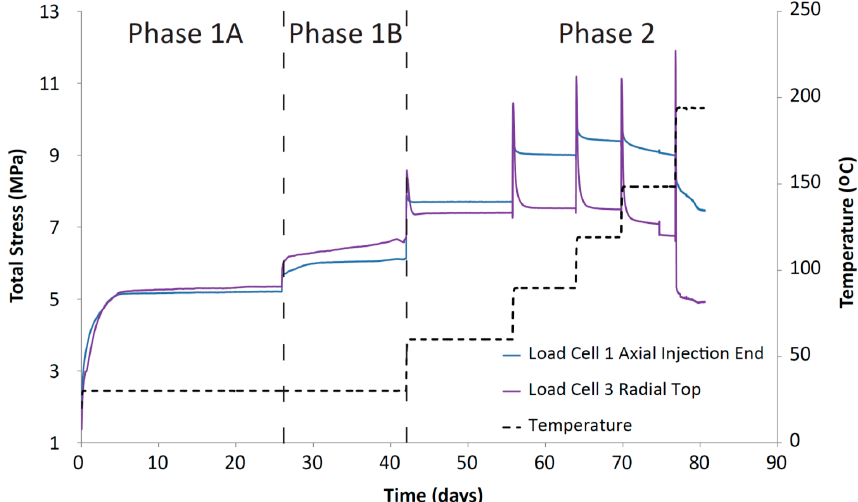
Figure 7. Total stress against time for the CVRF-2 experiment measured using the load cell stress sensors. Temperature (black dotted line) is shown. Load cells 2, 4 and 5 were inoperative at different points in the test and have been omitted from this graph. ( Phase 1A ) Hydration at 1 MPa (injection and backpressure); ( Phase 1B ) Injection pressure was equilibrated at 5 MPa for 15 days; ( Phase 2 ) Temperature was incrementally increased to 200 °C.